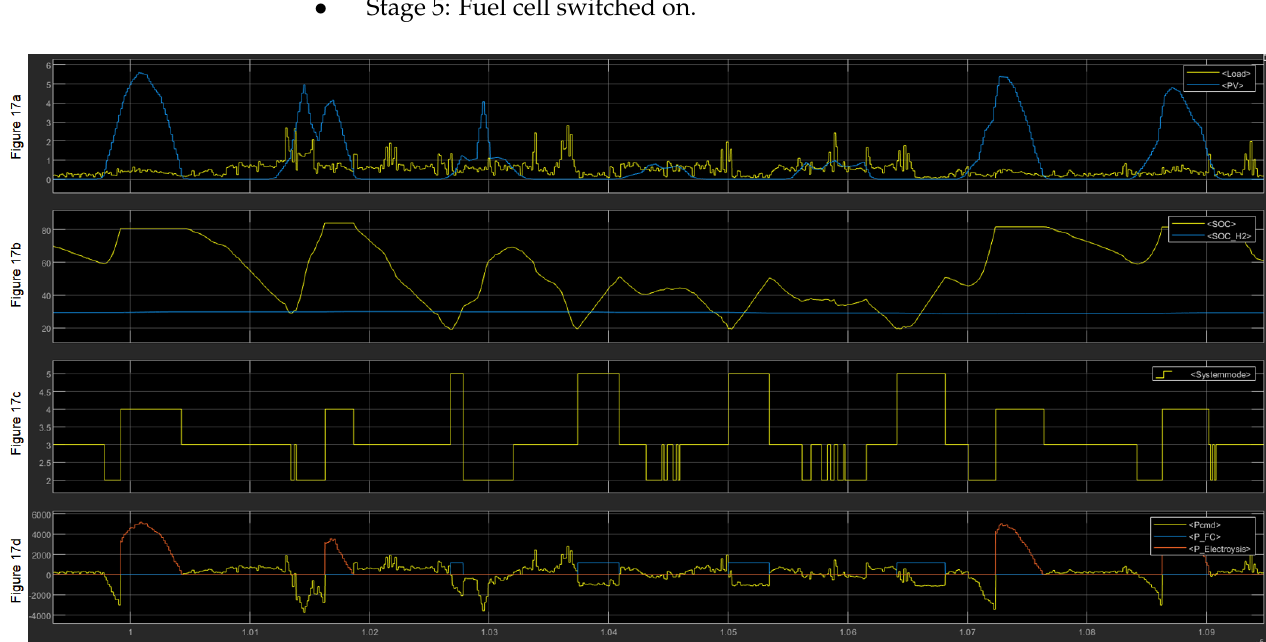
Figure 17. Simulation results for the week from 10 March to 16 March. First diagram (top ( a )): PV power (blue) and overall load (yellow); second diagram ( b ): SoC of Li-ion battery (yellow) and SoC of hydrogen storage (blue); third diagram ( c ): electrolyser turned on (yellow) and fuel cell turned on (blue); fourth diagram (bottom ( d )): energy provided by the fuel cell (blue), energy used inside the electrolyser (orange) and energy flow towards the Li-ion battery (negative value) and energy supplied by the Li-ion battery (positive value) (yellow), respectively.